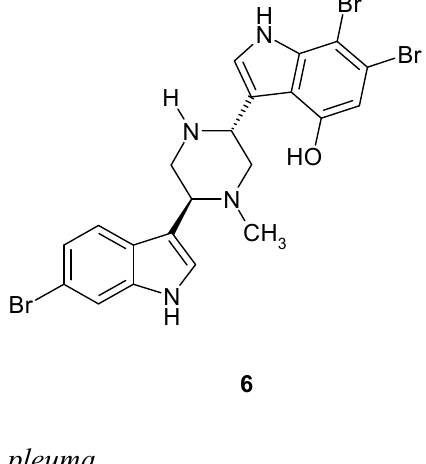
Figure 2. Structure of dragmacidin isolated from Dragmacidin sp.